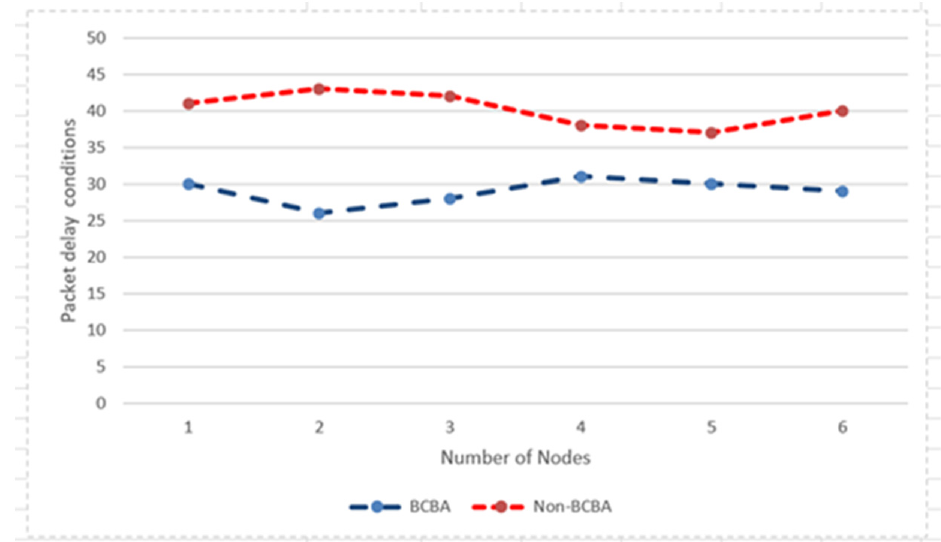
Figure 8. Comparison of packet delay between non-blockchain and blockchain-based techniques.